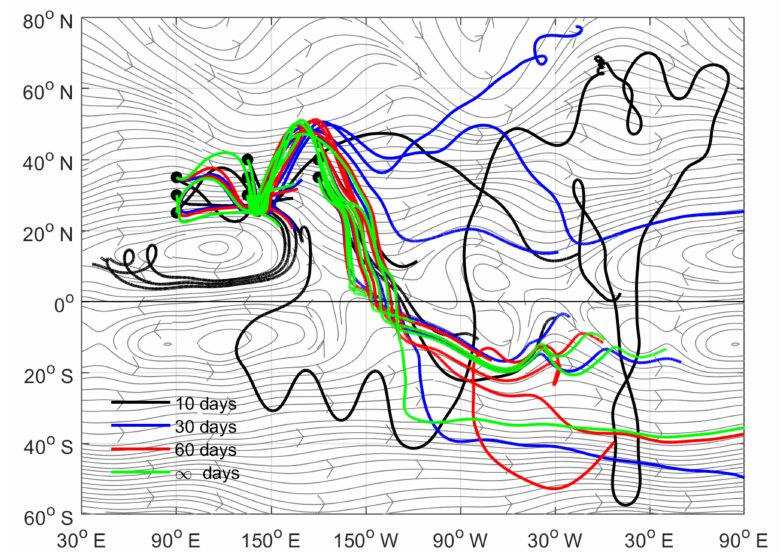
Figure 3. Ray paths of the 10 day (black), 30 day (blue), 60 day (red) and stationary waves (green) originated from the array of points (black solid points) in the eastern hemisphere. The streamlines represent the observed basic flow. The point locations are 90 ◦ E, 25 ◦ N; 90 ◦ E, 30 ◦ N; 90 ◦ E, 35 ◦ N;